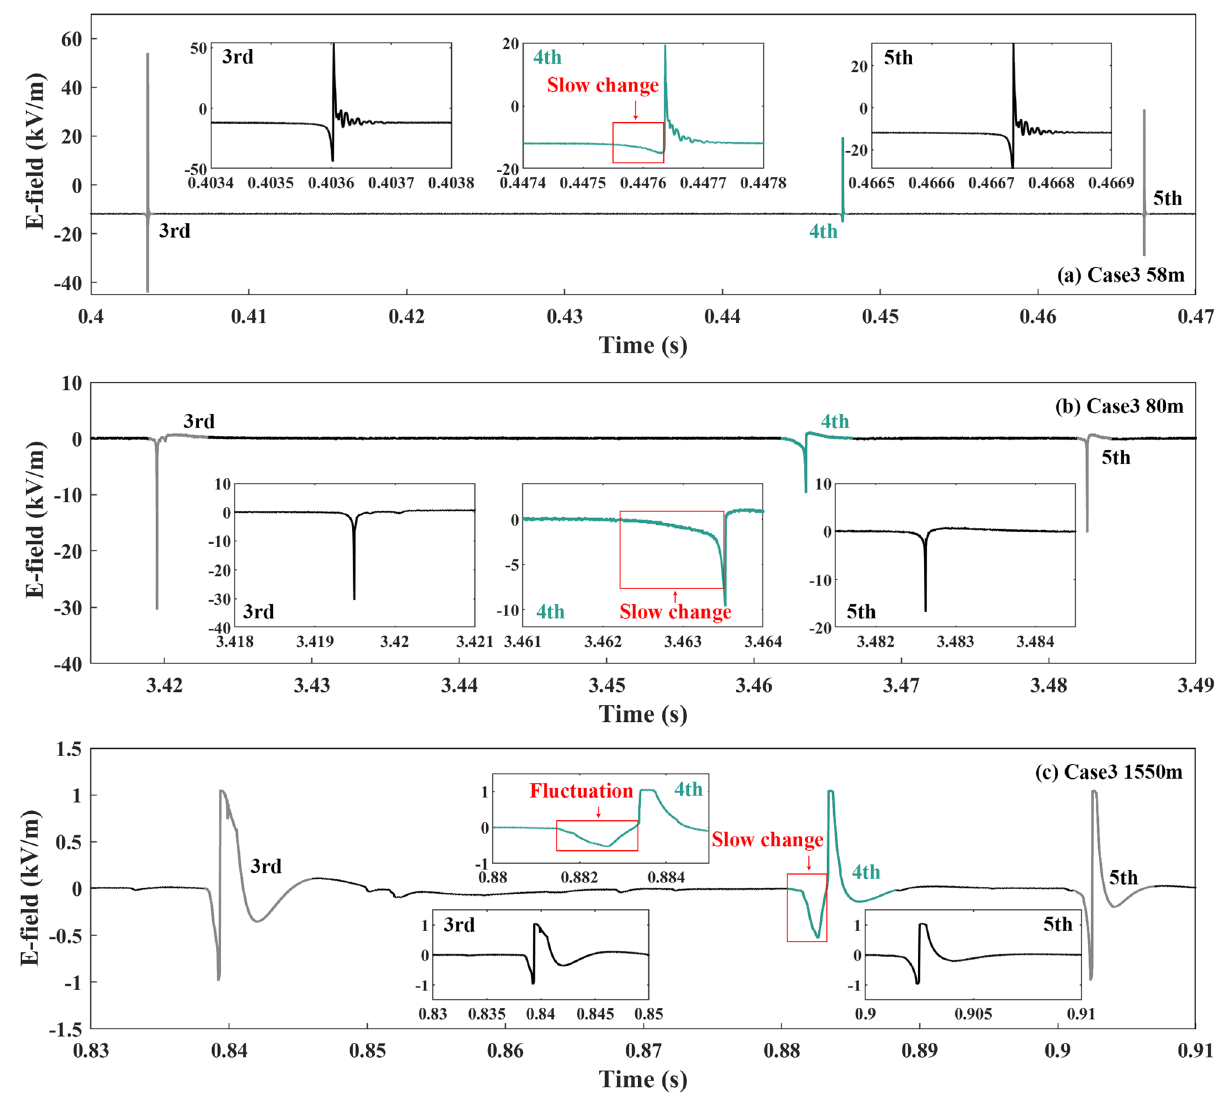
Figure 4. The E-field waveforms of Case 3 at different observation